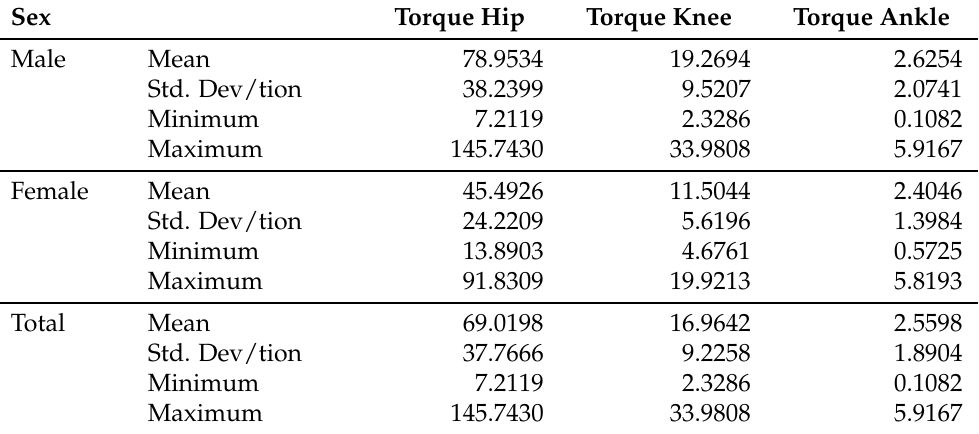
Table 8. Report Torque (Nm).